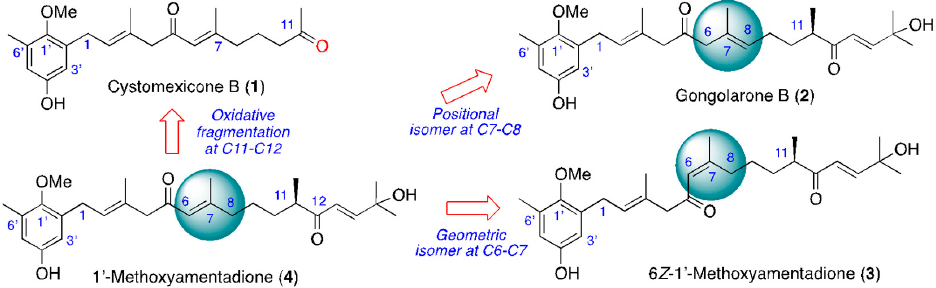
Figure 7. A structure–activity relationship analysis of the antikinetoplastid activity of compounds 1 – 4